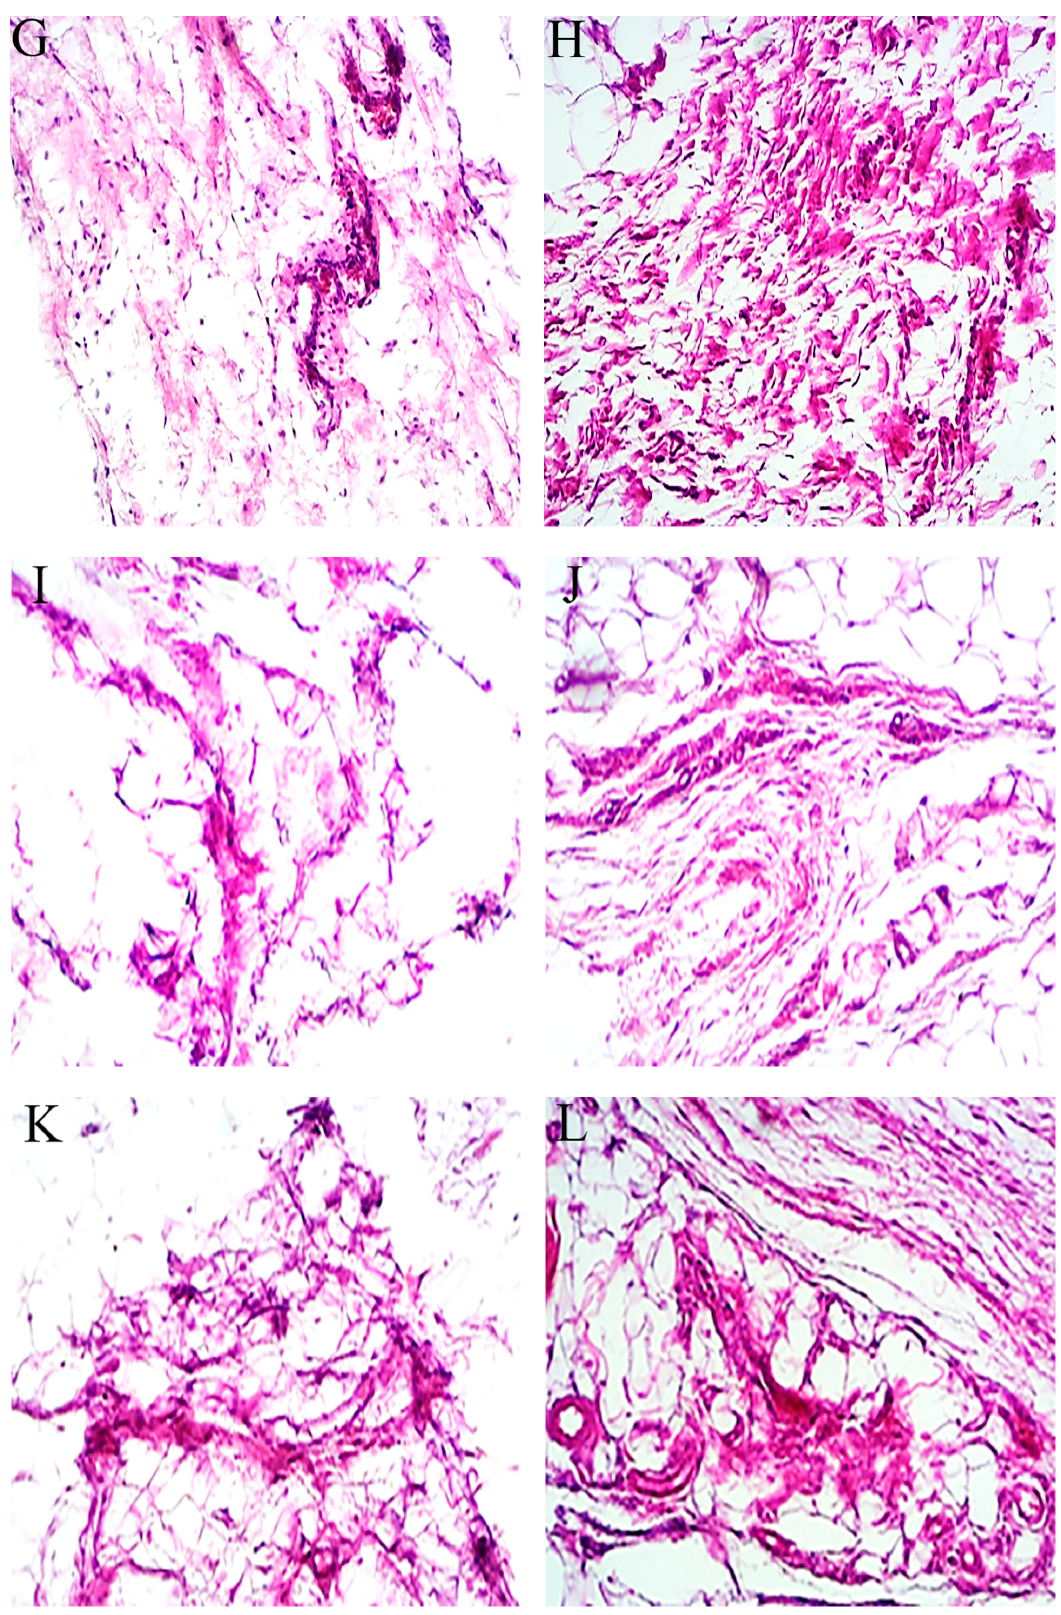
Figure 2. Light microscopic results of excised mass, revealing amyloid fibril deposits by Hematoxylin and Eosin (H&E) staining. ( A – L ) are × 40 magnifications, where Sham1 ( A – C ), Sham2 ( D – F ), Exp1 ( G – I ), and Exp2 ( J – L ) are represented. In each group, results of 6, 12, and 18 days of injection are shown from left to right (e.g., A: 6 days, B: 12 days, C: 18 days). Congo red is the most widely used stain for amyloid fibrils characterization, in which amyloids manifest themselves as pink or red stains under an ordinary light microscope [21]. It is an organic compound able to crosslink with cross-beta structures of amyloid fibrils [24]. Here, the amyloid fibrils are seen as dark-shade salmon pink deposits (Figure 3), and an increase in amyloid fibrils could be seen with increasing injection days. Congo red can also stain hyaline deposits, elastin, and collagen [25], and in order to better characterize the aggregates, an additional probe, namely Thioflavin-S, was also used.